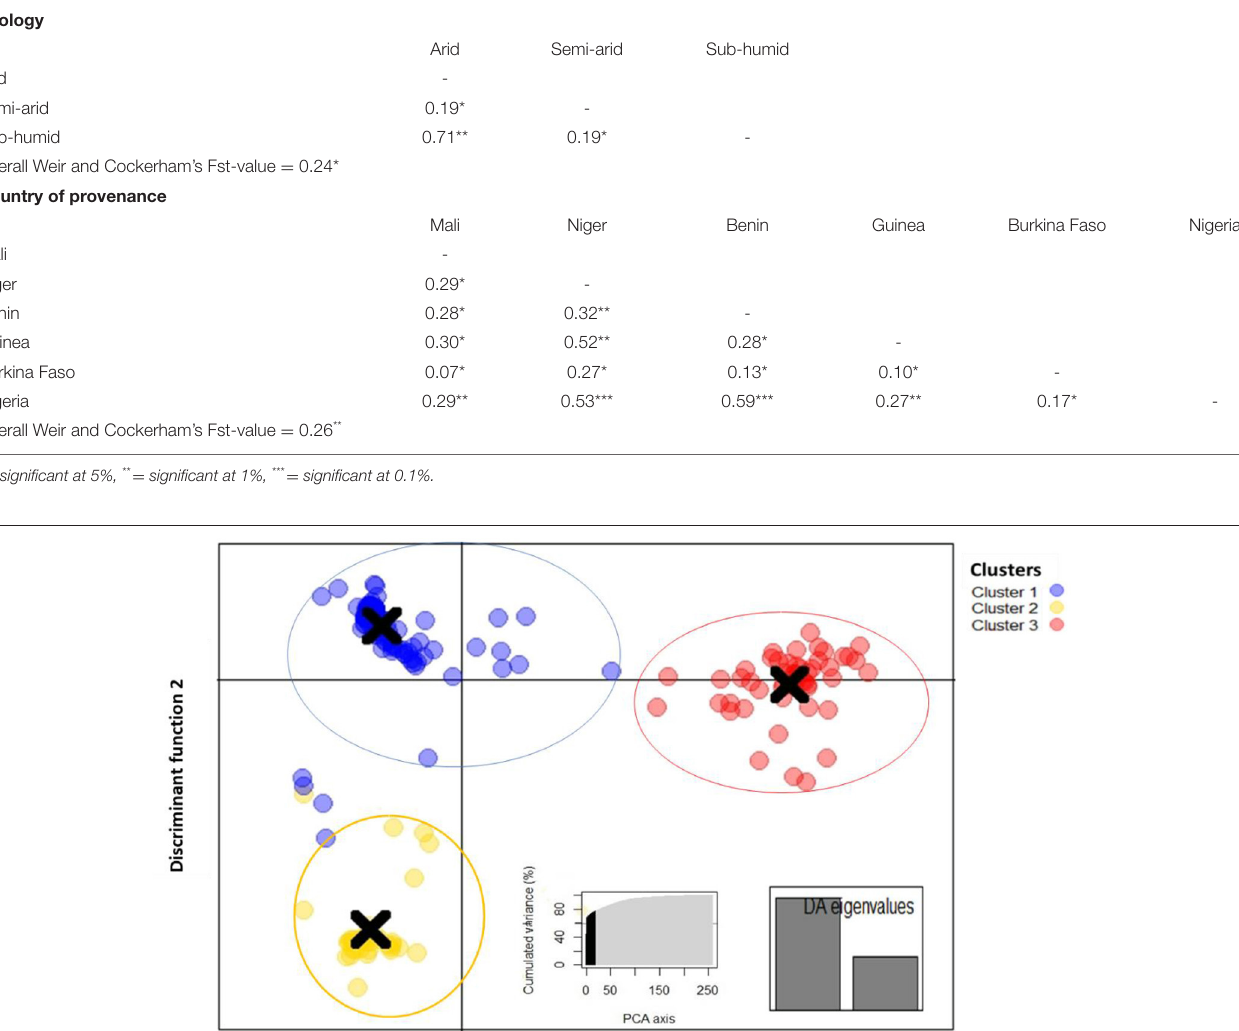
Southwestern Burkina Faso and Northern Nigeria. This